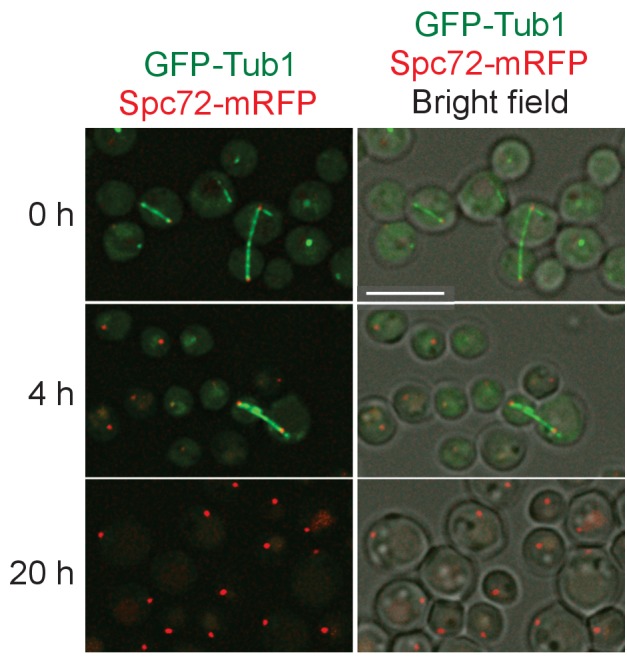
Spc72-mRFP accumulate at SPB in starvation conditions.Wild-type cells carrying SPC72-mRFP GFP-TUB1 (HPH449) grown in YPDS medium were transferred to NaKG medium and incubated for the indicated time. Scale bar, 5 µm.